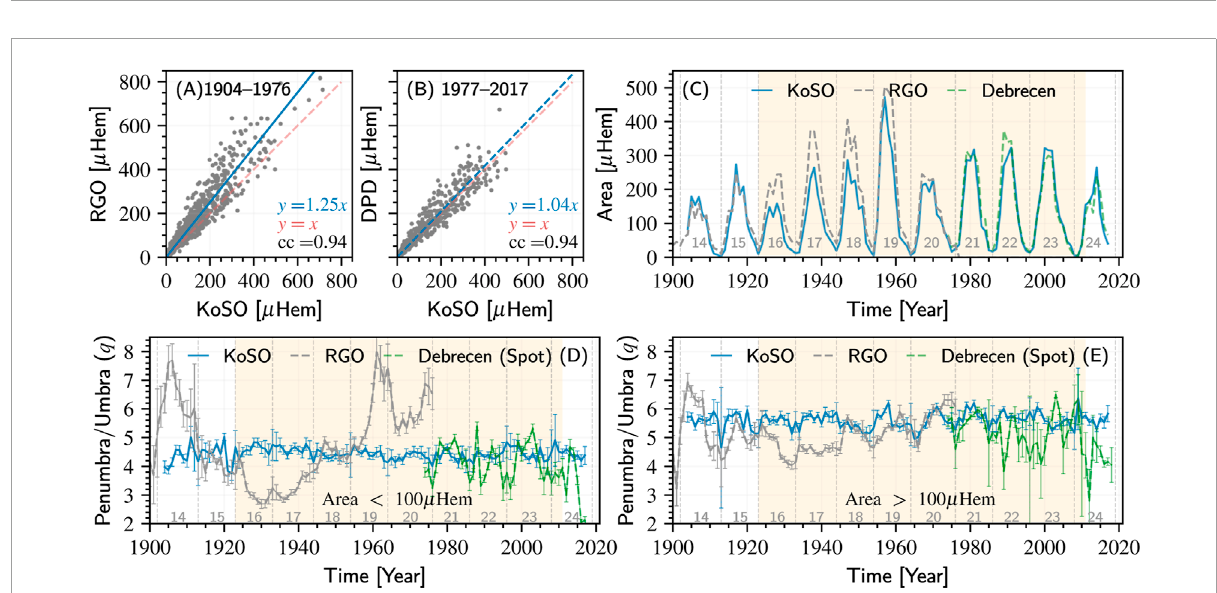
FIGURE 7 In panels (A) and (B) , we compare the KoSO monthly averaged umbra area with RGO and DPD umbra, respectively, in their corresponding periods. Panel (C) shows the solar cycle variation of yearly averaged umbra area compared to RGO and DPD umbra area. Panel (D) and (E) show the variation of q for smaller and larger sunspots for an extended period, respectively. The shaded regions represent the data used in Jha et al. (2019).